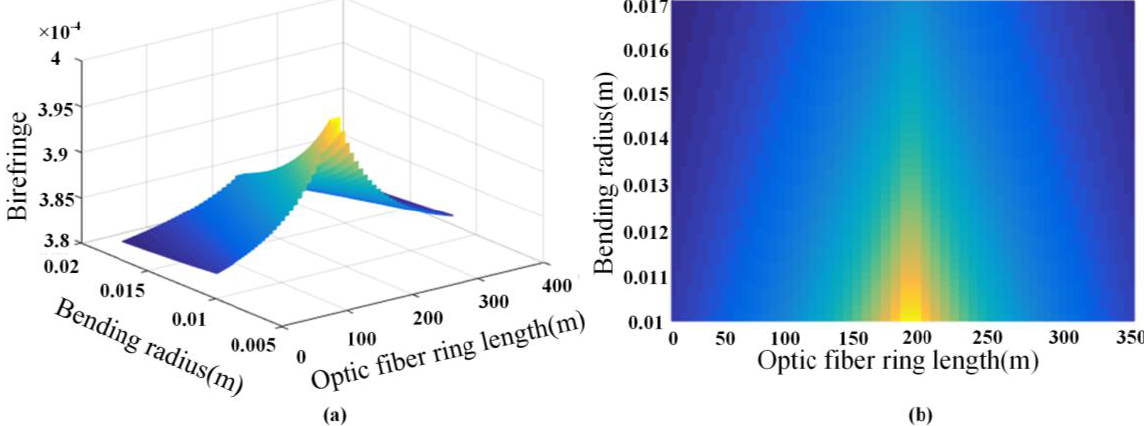
Figure 4. ( a ) Influence of bending radius and fiber coil length on birefringence distribution; ( b ) Distribution of birefringence over fiber coil length.